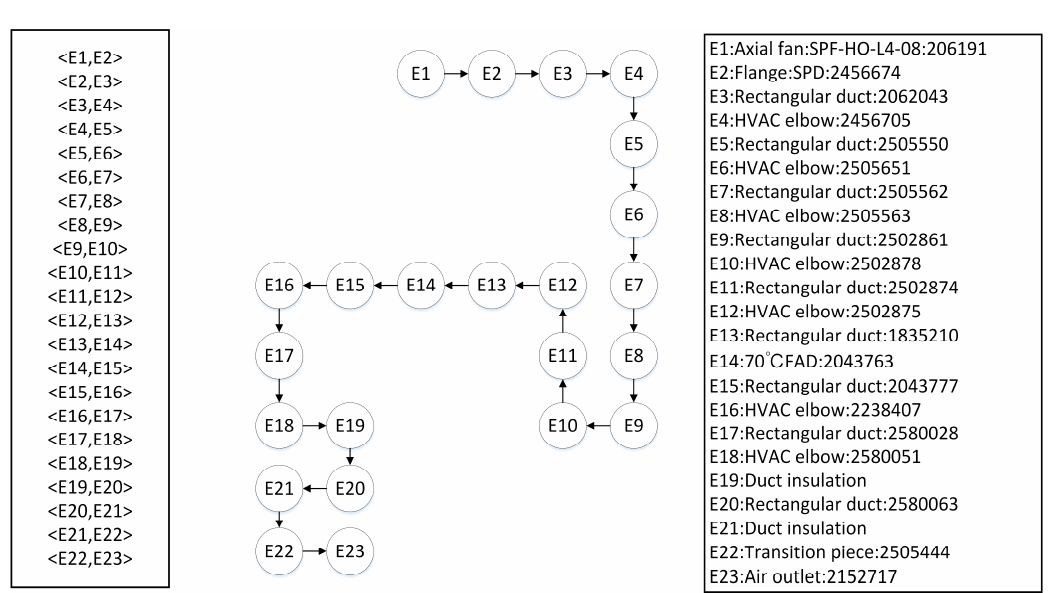
Figure 13. Data structure of a supply air system.